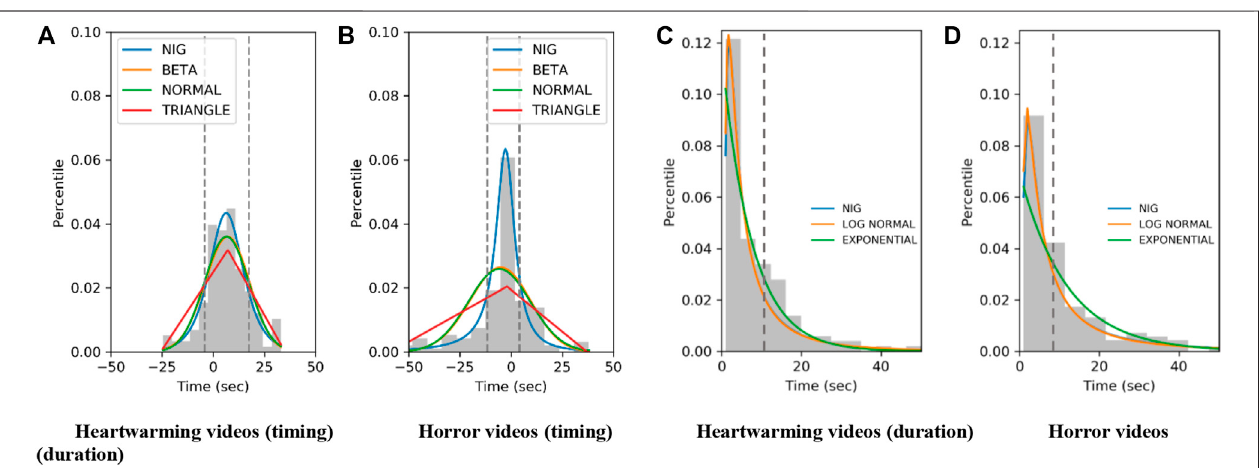
FIGURE3| Histogramsofgriptimingand durationand fi ttingresultswithfunctions. (A) Heartwarmingvideos (timing). (B) Horror videos(timing). (C) Heartwarming videos (duration). (D) Horror videos (duration).